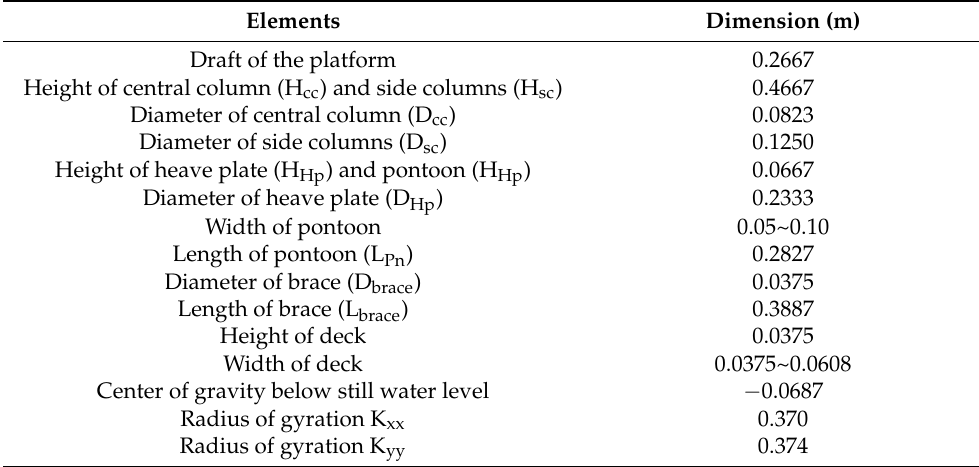
Table 1. Dimension and hydrostatic properties of the semi-submersible